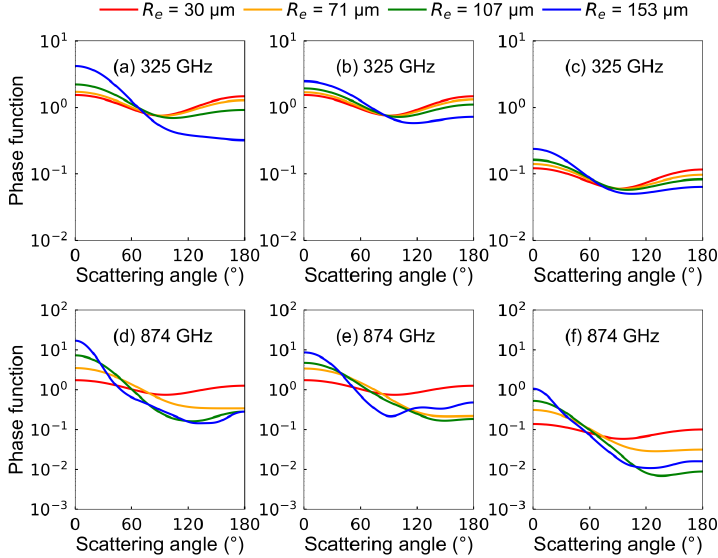
Figure 5. The scattering phase functions for ice particles with four sizes ( R e = 30, 71, 107, and 153µm) for the (a, d) Voronoi, (b, e) sphere, and (c, f) column ICS models with a refractive index of 1 . 78 + 0 . 005 i in the 325GHz and 1 . 78 + 0 . 015 i in the 874GHz, respectively.